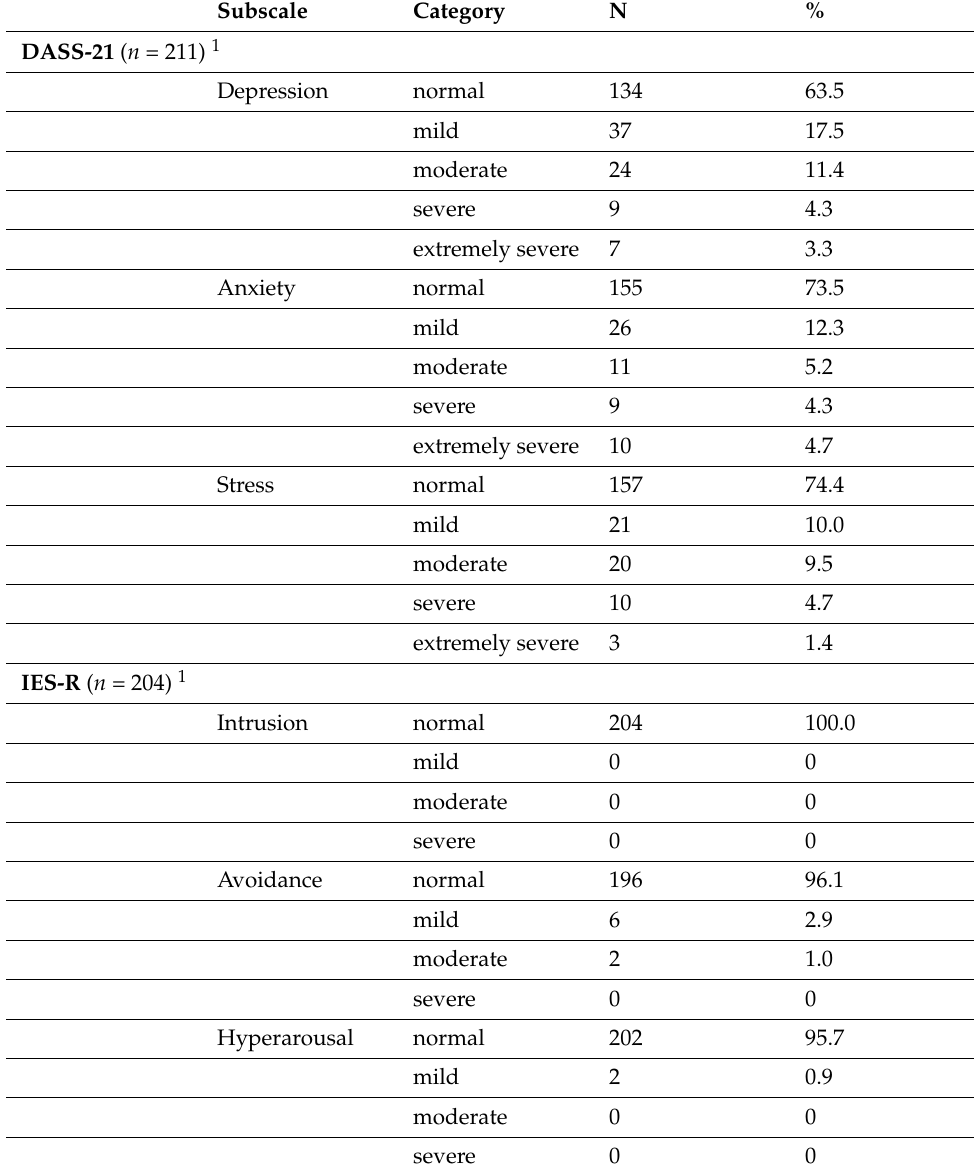
Table 3. The number of dental students and total population percentage for each DASS-21 and IES-R subscale